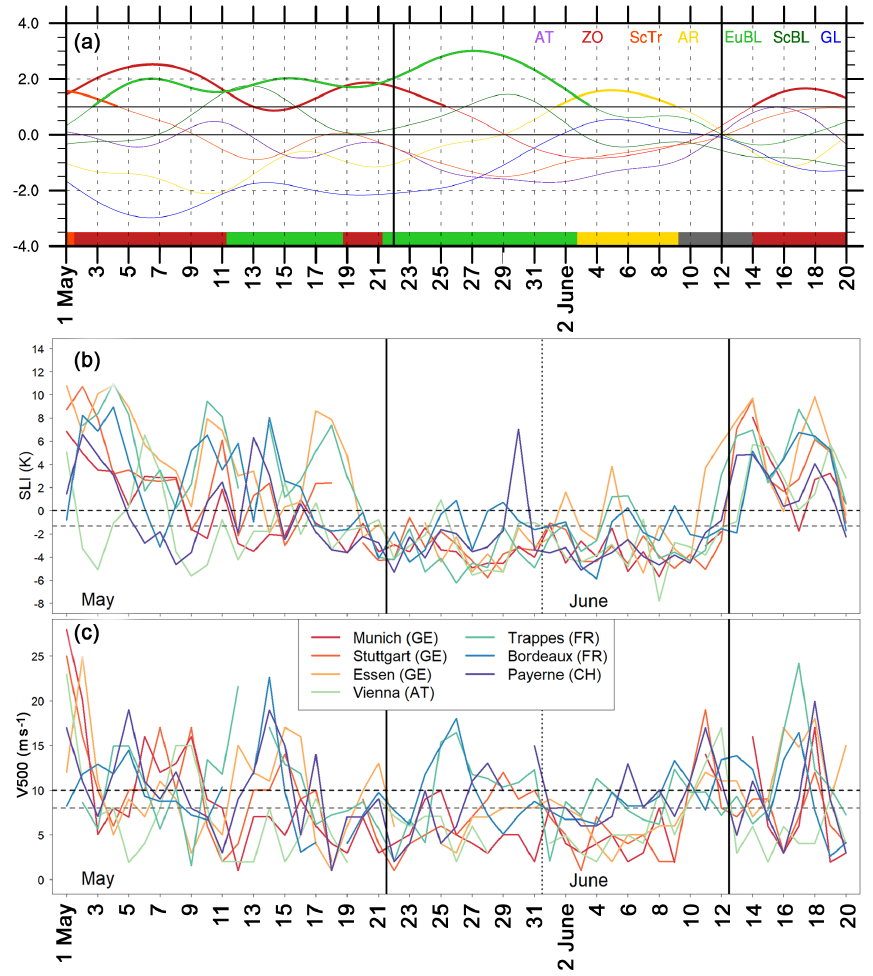
Figure 7. Time series of three different parameters during the extended study period from 1 May to 20 June 2018: (a) Atlantic–European weather regime life cycles based on the normalized projection into all seven regimes (coloured curves, based on ECMWF analysis). Active regime life cycles with a projection > 1 . 0 and persistence of at least 5d are highlighted with bold curves (see Sect. 2.3), the dominant regime (maximum projection and active life cycle) is marked at the bottom. Relevant active regime life cycles are zonal regime (ZO, dark red), European blocking (EuBL, light green), Atlantic Ridge (AR, yellow), no regime (grey). (b) Surface-based lifted index (SLI in K) and (c) horizontal wind speed at 500hPa ( V 500 in ms − 1 ) for the 12:00UTC sounding at seven European stations. Horizontal dashed black and grey lines indicate thresholds as defined in PIP16 (basic criterion: 0K and 10ms − 1 ; strict criterion: − 1 . 3K and 8ms − 1 ; see Sect. 2.6). Vertical black lines indicate the study